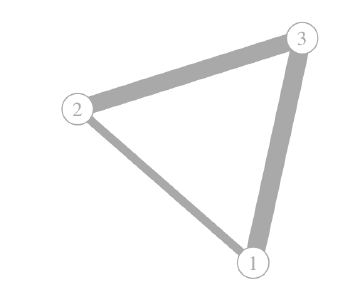
Figure 3: The Tail Dependograph of the stdf